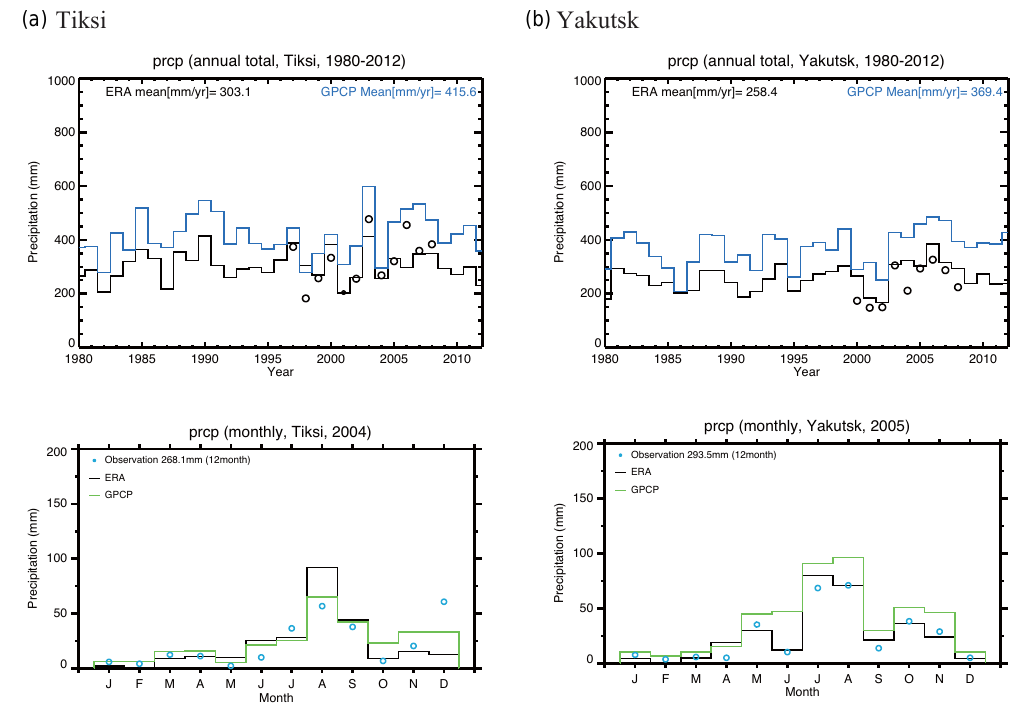
Figure 5. Comparison of annual (upper) and monthly (lower) precipitation amounts between ERA-Interim, GPCP, and observations (nearby stations). Examples show results for (a) Tiksi (left) and (b) Yakutsk (right). Annual precipitation is shown for period 1980–2012, and the monthly values are taken from 2004 for Tiksi and from 2005 for Yakutsk for exemplary purpose. Observations are shown as open circles, ERA data in black lines, and GPCP data in green lines. The annual value for 2001 for Tiksi is shown by a small filled circle for contrast because of exceptionally frequent missing data (151 days) in the